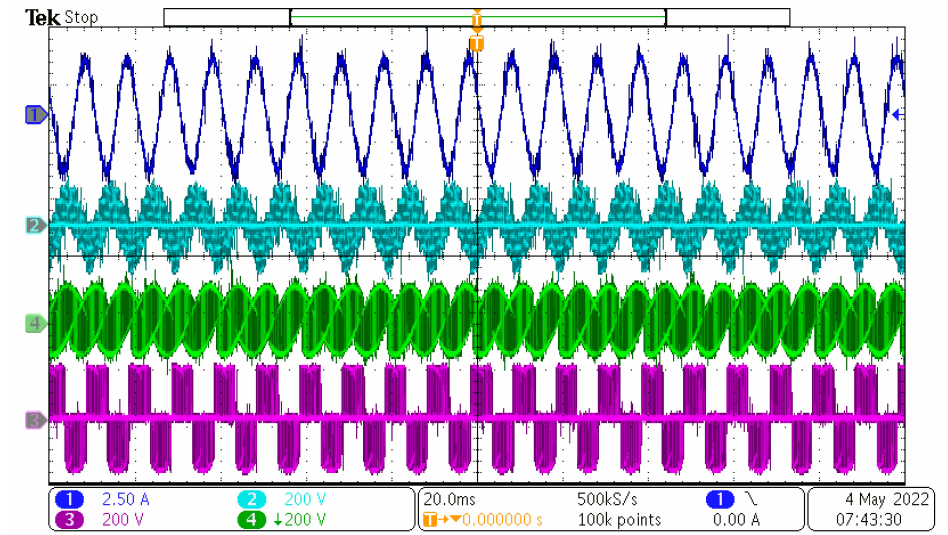
Figure 14. Measured results at f IN = 50 Hz and f OUT = 100 Hz. CH1—output current, CH2—output load voltage, CH3—output phase to phase voltage, CH4—output phase to input neutral